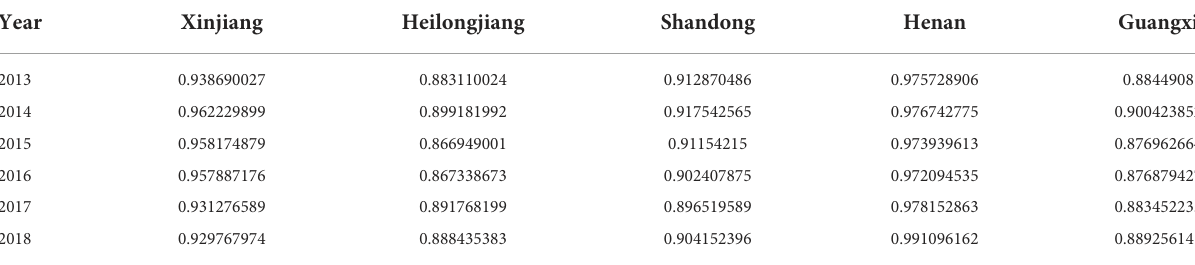
TABLE 3 Correlation analysis between agricultural production structure and educational development equality in main agricultural production areas. Index Model selection Curve estimation: composite Curve estimation: composite Curve estimation: inverse Curve estimation: power Curve estimation: